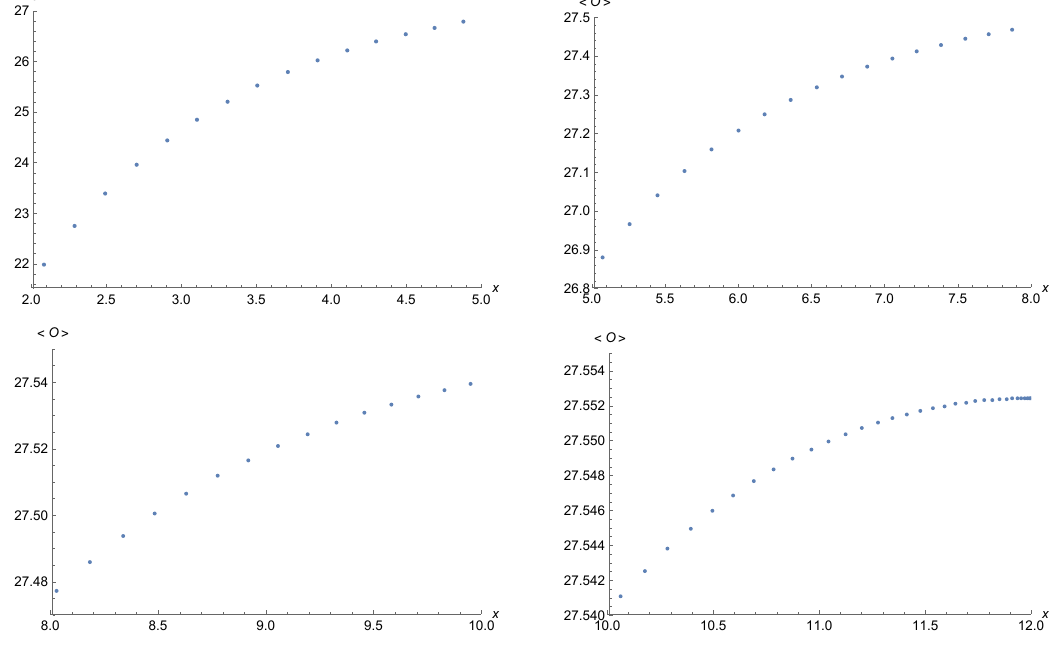
Figure 9 . The magni(cid:12)ed order parameter under the alternative quantization with the chemical potential (cid:22) = 5 : 5. It can be seen that the order parameter monotonously increases in the x direction.